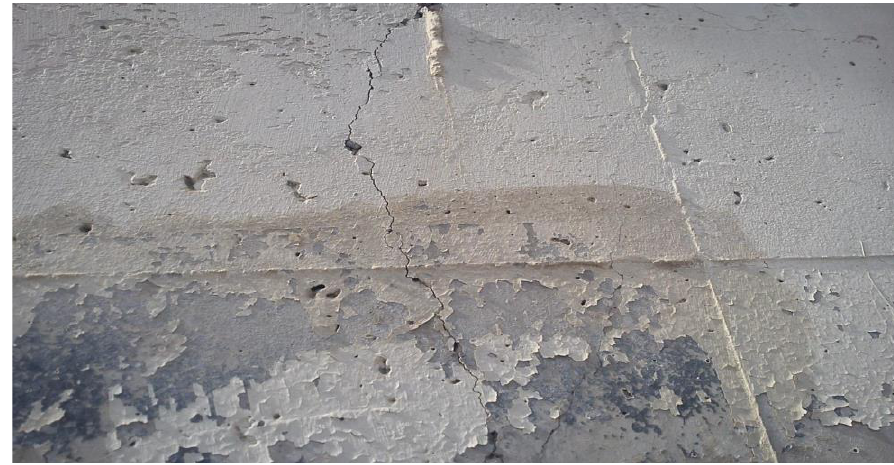
Figure 6. The structure of the bridge No. 1.